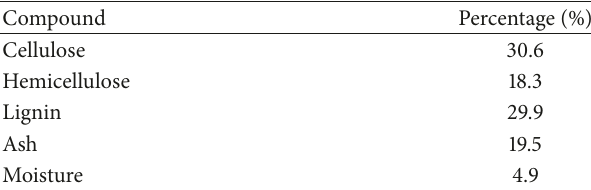
Table 1: Raw rice husk chemical composition.